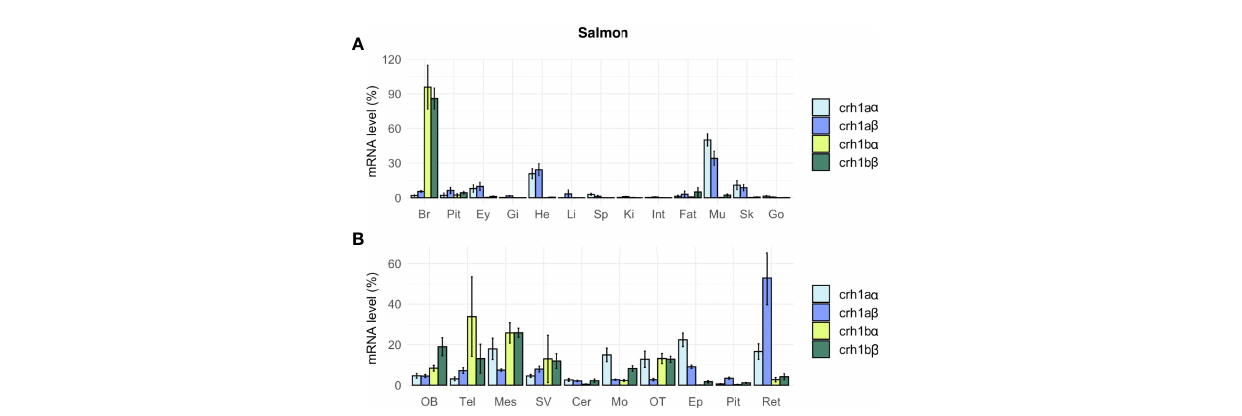
FIGURE 7 | Tissue distribution of crh paralogs in juvenile Atlantic salmon as measured by qPCR. (A) crh1a a , crh1a b , crh1b a and crh1b b expression in the brain (Br), pituitary (Pit), eyes (Ey), aand various peripheral organs, gills (Gi), heart (He), liver (Li), spleen (Sp), kidney (Ki), intestine (Int), fat (Fat), muscle (Mu), skin (Sk) and gonad (Go). (B) crh1a a , crh1a b , crh1b a and crh1b b expression in various brain regions: olfactory bulb (OB), telencephalon (Tel), mesencephalon (Mes), diencephalon (Di), saccus vasculosus (SV), cerebellum (Cer), medulla oblongata (Mo), optic tectum (OT), epiphysis (Ep), pituitary (Pit) and retina (Ret). Results (means ± SEM; n=8-10) are presented as percentage per